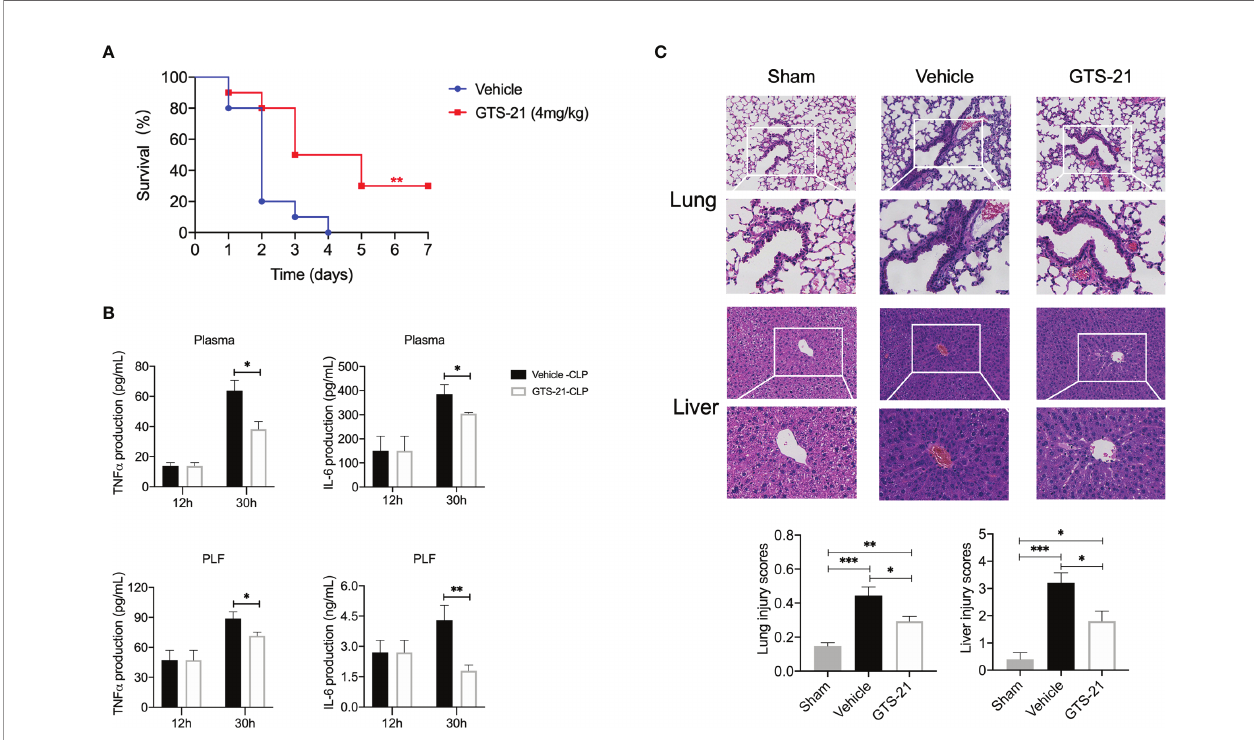
FIGURE 1 | GTS-21 treatment suppresses local and systemic cytokines, alleviates histopathology damage, and improves survival rates during CLP-induced septic peritonitis. Mice were subjected to CLP, and GTS-21 or vehicle was injected intraperitoneally 12h after CLP procedure and repeated every 12h for three consecutive days. (A) The survival rates were evaluated for consecutive 7 days after CLP (n=10 mice/group). (B) PLF and blood samples were collected ( n =6~8 mice/group) at an indicated time point, and the levels of TNF- a and IL-6 were measured using ELISA kits. (C) Lung and liver samples were obtained 30h after CLP ( n =5 mice/group) and stained for H&E histopathology (original magni fi cation, × 100 and ×200). The slides were histopathologically evaluated as described in Materials and Methods. All values represent means ± SEM. * p < 0.05; ** p < 0.01; *** p < 0.001 for GTS-21 vs